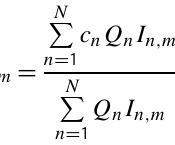
Figure 11: scenario with pumping equal to 50 m 3 /d with well density of 0.625 well/ha